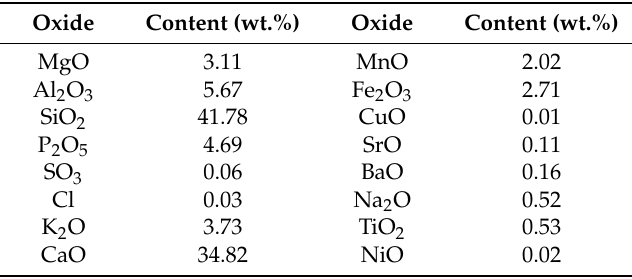
Figure 5. Incrust from the grate section of generator. Table 8. Incrust composition.